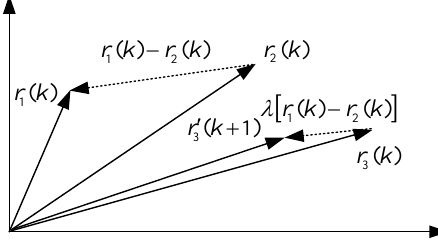
Fig. 2. Principle of Differential Evolution (DE)